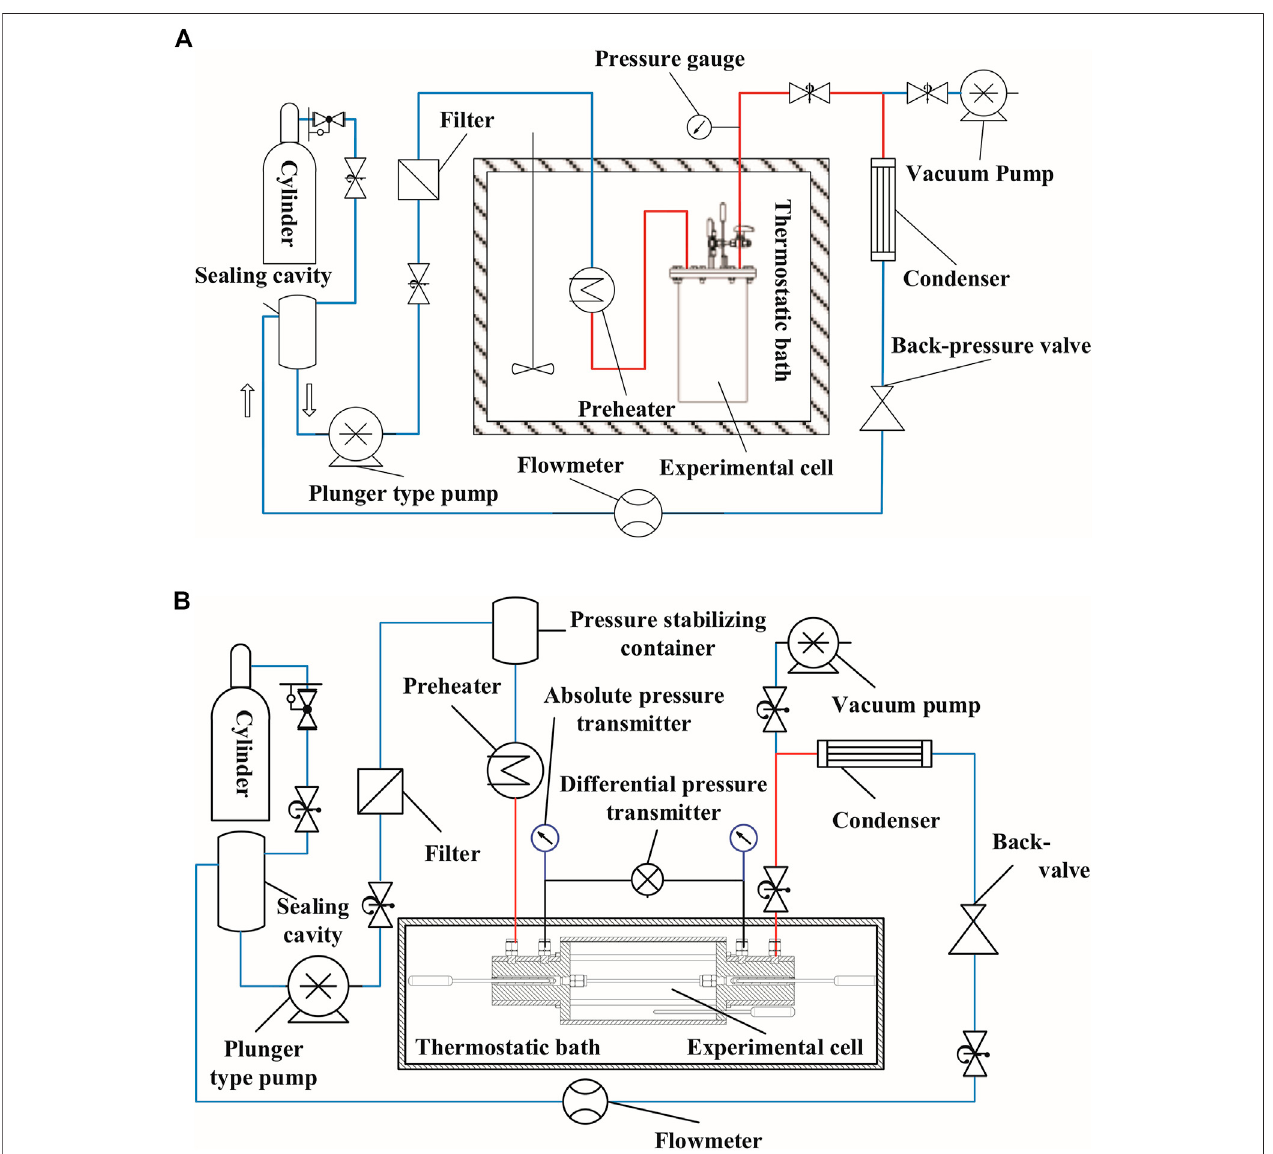
FIGURE 1 | Schematic diagram of the experimental apparatus: (A) c p measurement (B) ρ and η measurement.